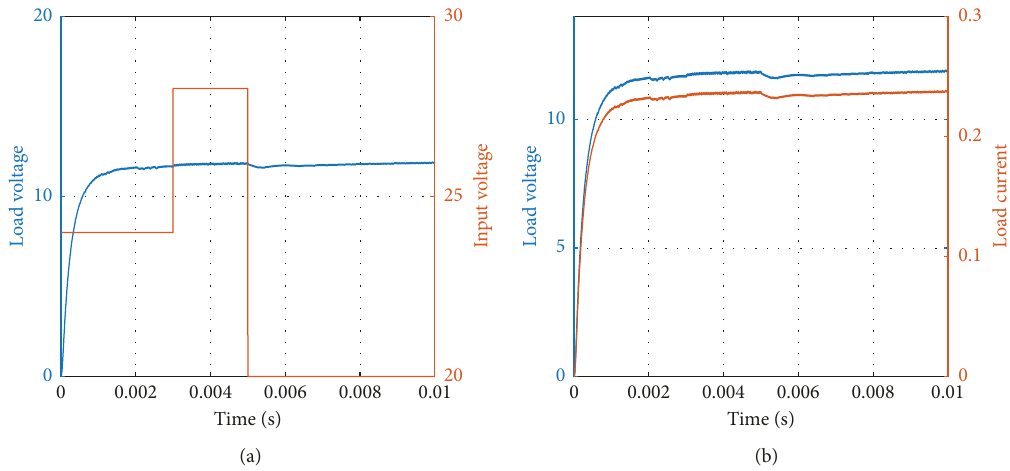
Figure 12: Plot for (a) output voltage across load under variable input voltage and (b) output current and voltage for varying input voltage using the QFT controlled proposed by Ibarra.